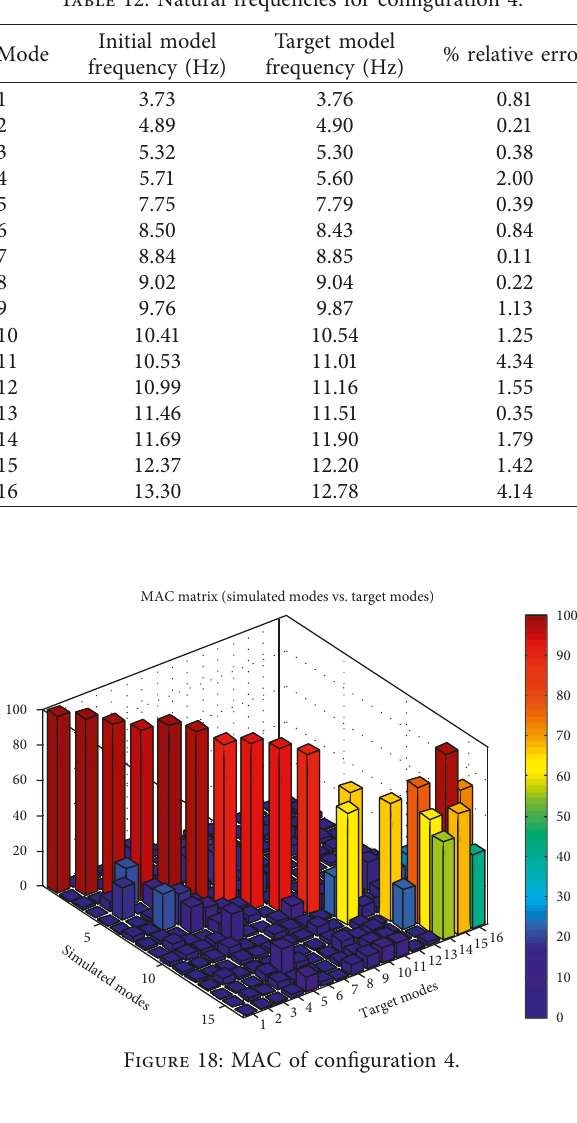
Table 12: Natural frequencies for configuration 4.